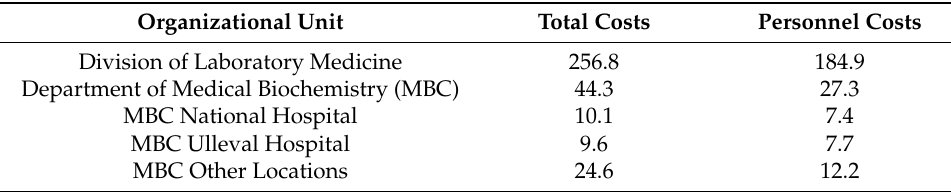
Table 1. Total costs of all laboratory services in the Division of Laboratory Medicine and the costs related to the Department of Medical Biochemistry for 2018. The Department of Medical Biochem- istry is organized at four locations. (Annual costs in million Euro. Average exchange rate 2018 NOK/ € = 9.4).